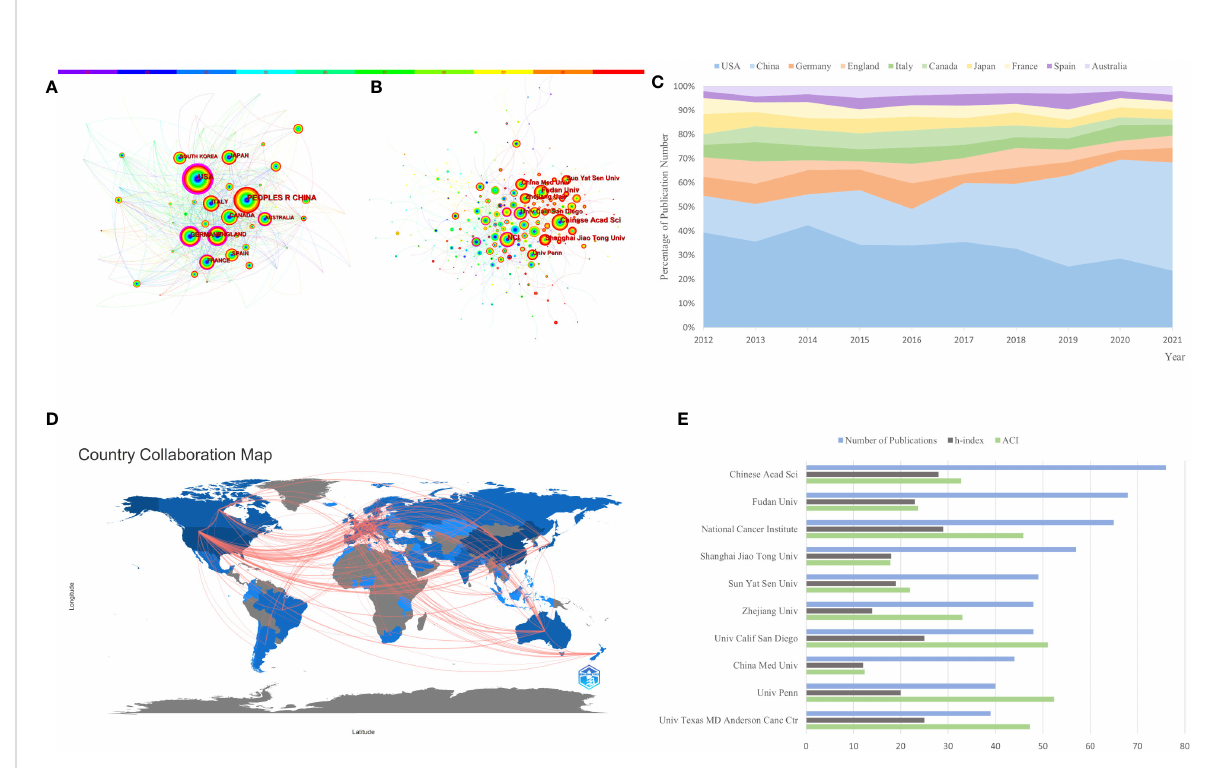
FIGURE 3 The co-occurrence atlas of (A) countries/regions ( n ≥ 100) and (B) academic institutions ( n ≥ 40) in alternative splicing of cancer research. As time passes from 2012 to 2021, the color of the node and line changes from purple to red. Purple-round nodes indicate strong betweenness centrality ( ≥ 0.1). (C) The relative fraction of annual publications in the top 10 countries from 2012 to 2021. (D) Network diagram of countries/ regions (min edges = 2) involved in alternative splicing of cancer research. (E) The top 10 most productive institutions ’ publication counts, h- index, and ACI.